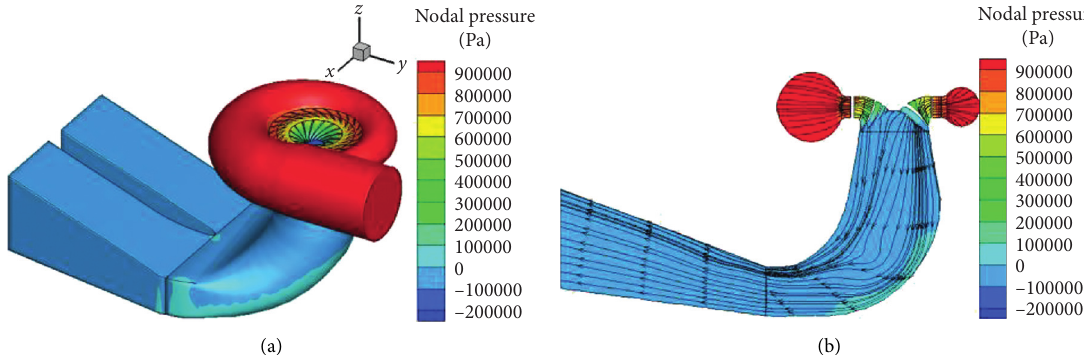
Figure 7: Instantaneous nodal pressure and streamlines distribution in the whole flow domain. (a) Nodal pressure in the whole domain. (b) Nodal pressure and streamlines in the meridian plane.